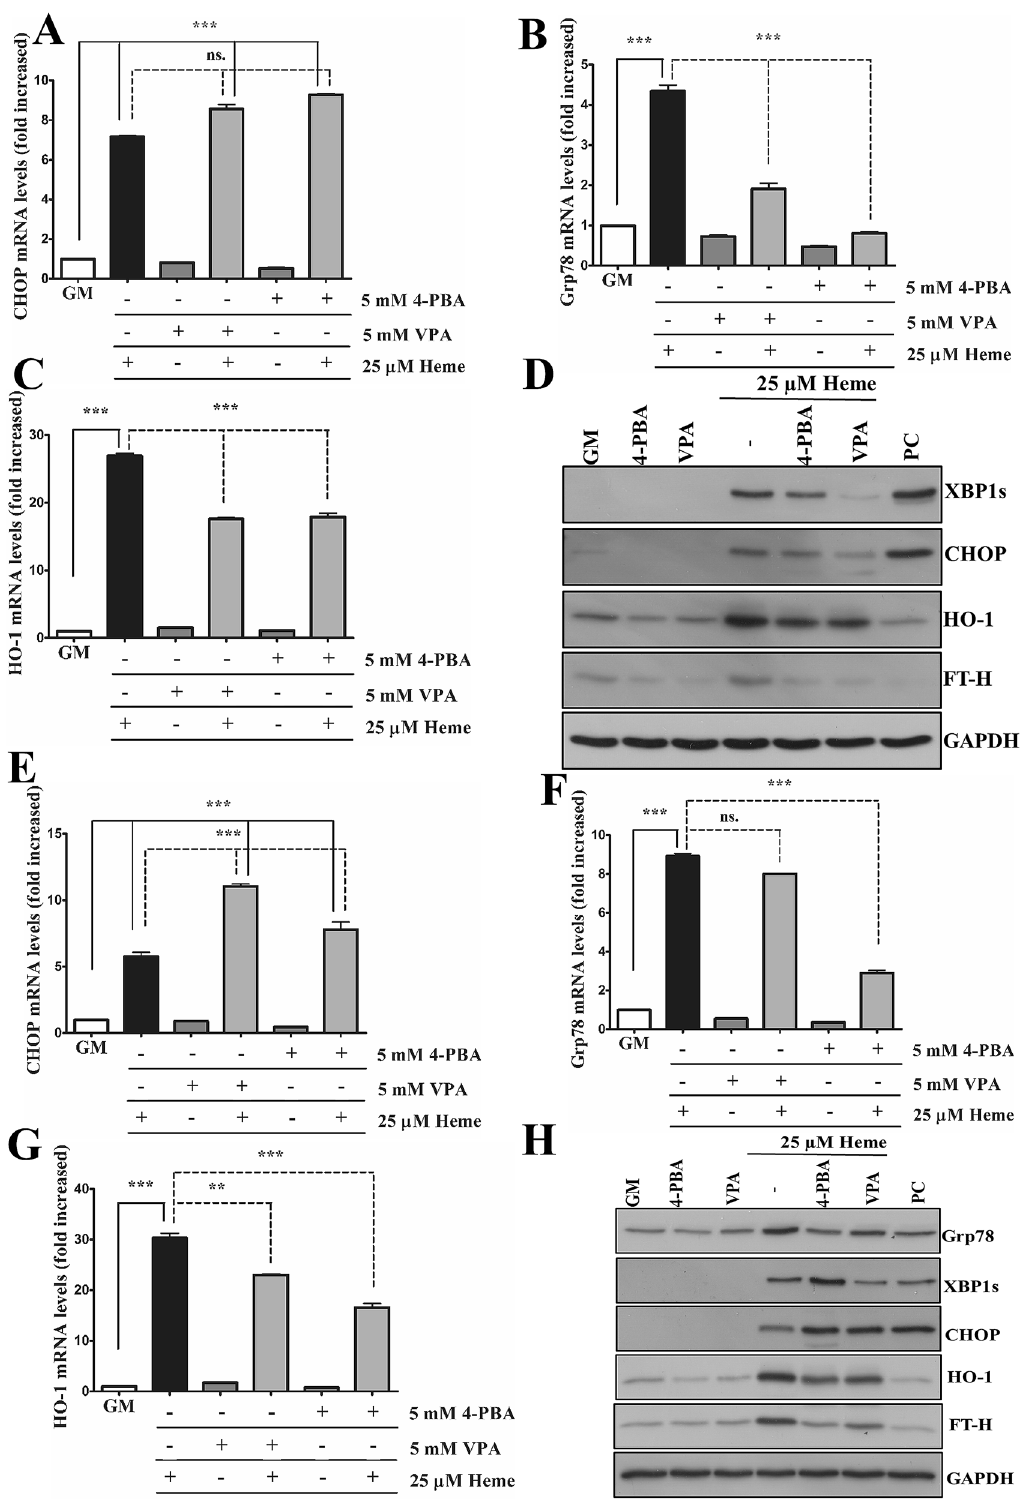
Figure 4. ER stress inhibitors does not protect against HIER stress. ECs were pre-incubated with either 4-phenylbutyric acid (4-PBA) (5 mM) or valproic acid (VPA) (5 mM) overnight, then exposed to heme (25 µM) in serum- and antibiotics-free CM199 supplemented with either 4-PBA (5 mM) or VPA (5 mM), then further incubated with CM199 supplemented with 10% FCS, antibiotics, and either 4-PBA (5 mM) or VPA (5 mM) for 3 h and 6 h. ( A ) Relative expression of CHOP, ( B ) Grp78, and ( C ) HO-1 were analyzed after 3 h and ( E ) CHOP, ( F ) Grp78, ( G ) HO-1 6 h. Representative immunoblots of three independent experiments are shown representing Grp78, spliced XBP1, CHOP, HO-1, and ferritin heavy chain levels after ( D ) 3 and ( H ) 6 h. GM growth medium, VC vehicle control, PC positive control. Data are shown as mean ± SEM of three independent experiments. Immunoblots are cropped from different parts of the same gel. Uncropped immunoblots are presented in the Supplementary information. Statistical analysis was performed by one- way ANOVA test followed by Bonferroni correction. A value of p < 0.05 was considered significant. * p < 0.05, * p < 0.01, *** p <